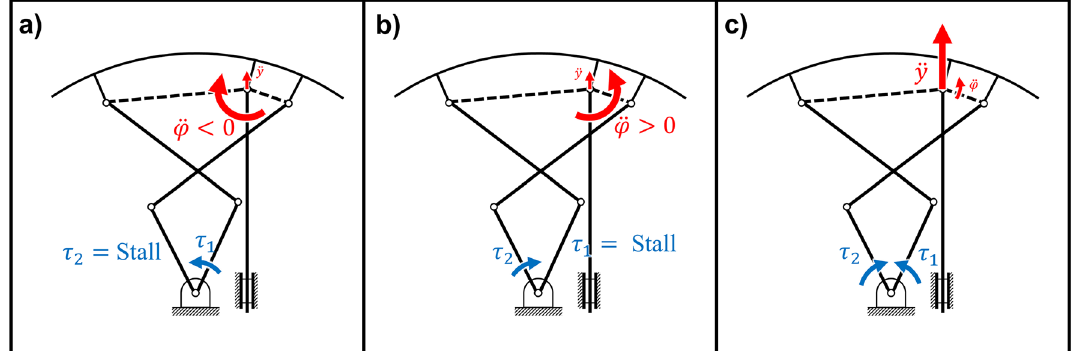
Figure 6. Three manipulator directions for the output of the mechanism. The input torque and speed are equal to those listed in the motor specifications. The dominant output is highlighted by wider red arrows.